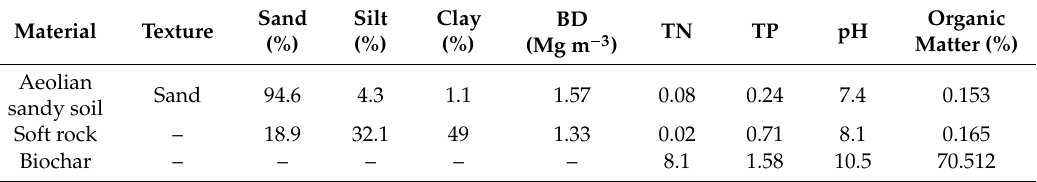
Table 2. Primary physical properties of sand soil, biochar, and soft rock in the study